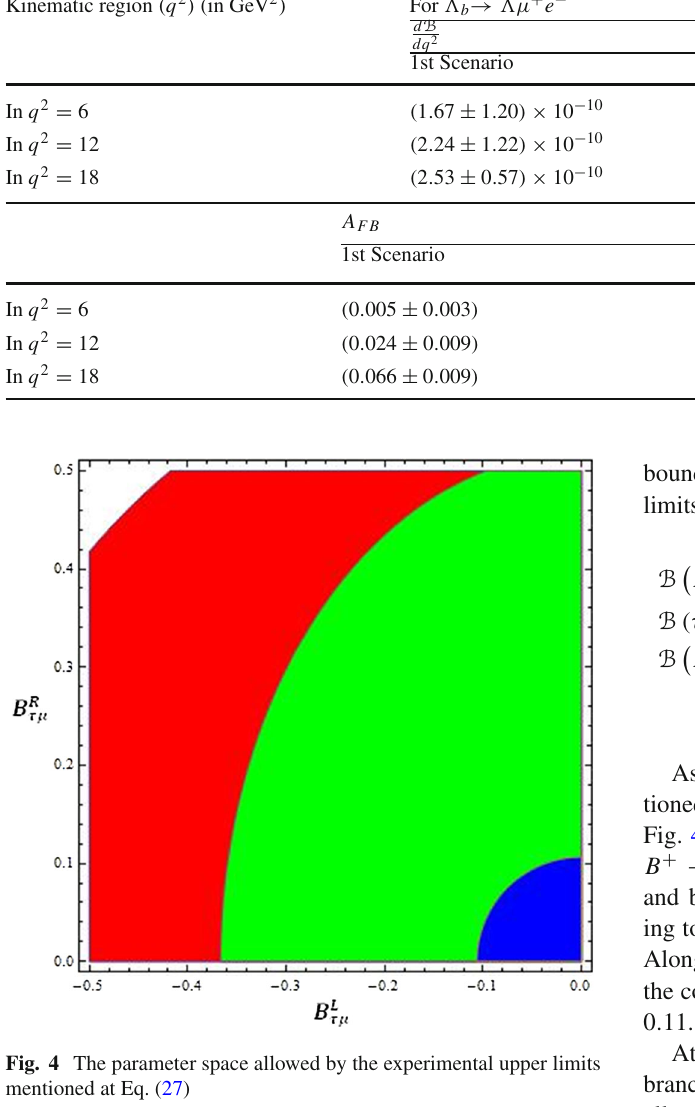
Table 2 Predicted values of differential branching ratios and forward backward asymmetries for (cid:2) b → (cid:2)μ + e − decay in 1st, 2nd and 3rd scenarios Kinematic region ( q 2 ) (in GeV 2 )